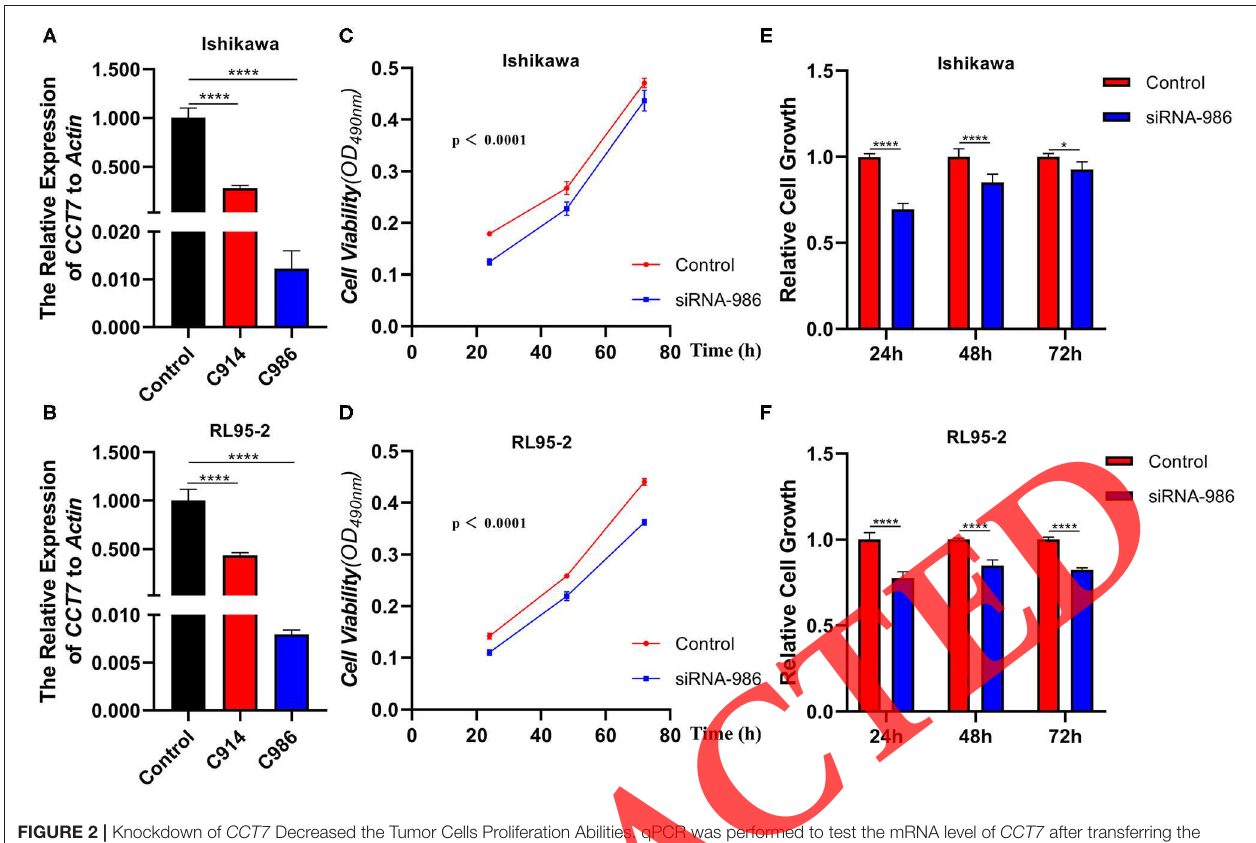
FIGURE 2 | Knockdown of CCT7 Decreased the Tumor Cells Proliferation Abilities. qPCR was performed to test the mRNA level of CCT7 after transferring the CCT7 -siRNA into Ishikawa and RL95-2 cells (A,B) . Proliferative abilities of Ishikawa and RL95-2 cells treated with CCT7 siRNA-986 were determined using an MTT assay after culturing for 24, 48, 72h (C–F) . * p < 0.05, **** p < 0.0001, all values represent Mean ±